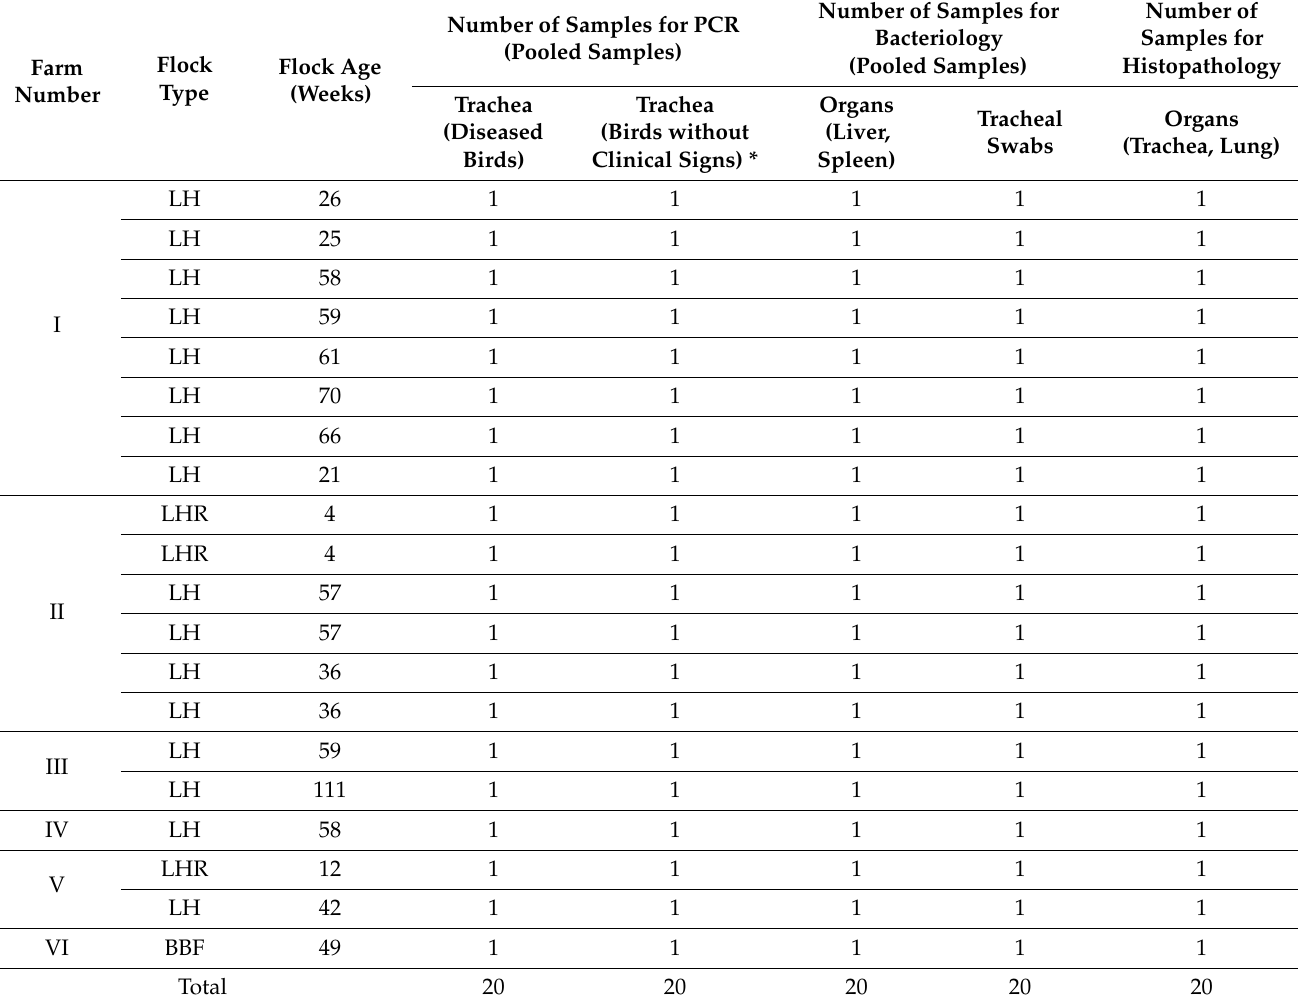
Table 2. Data on the number of collected samples from the examined